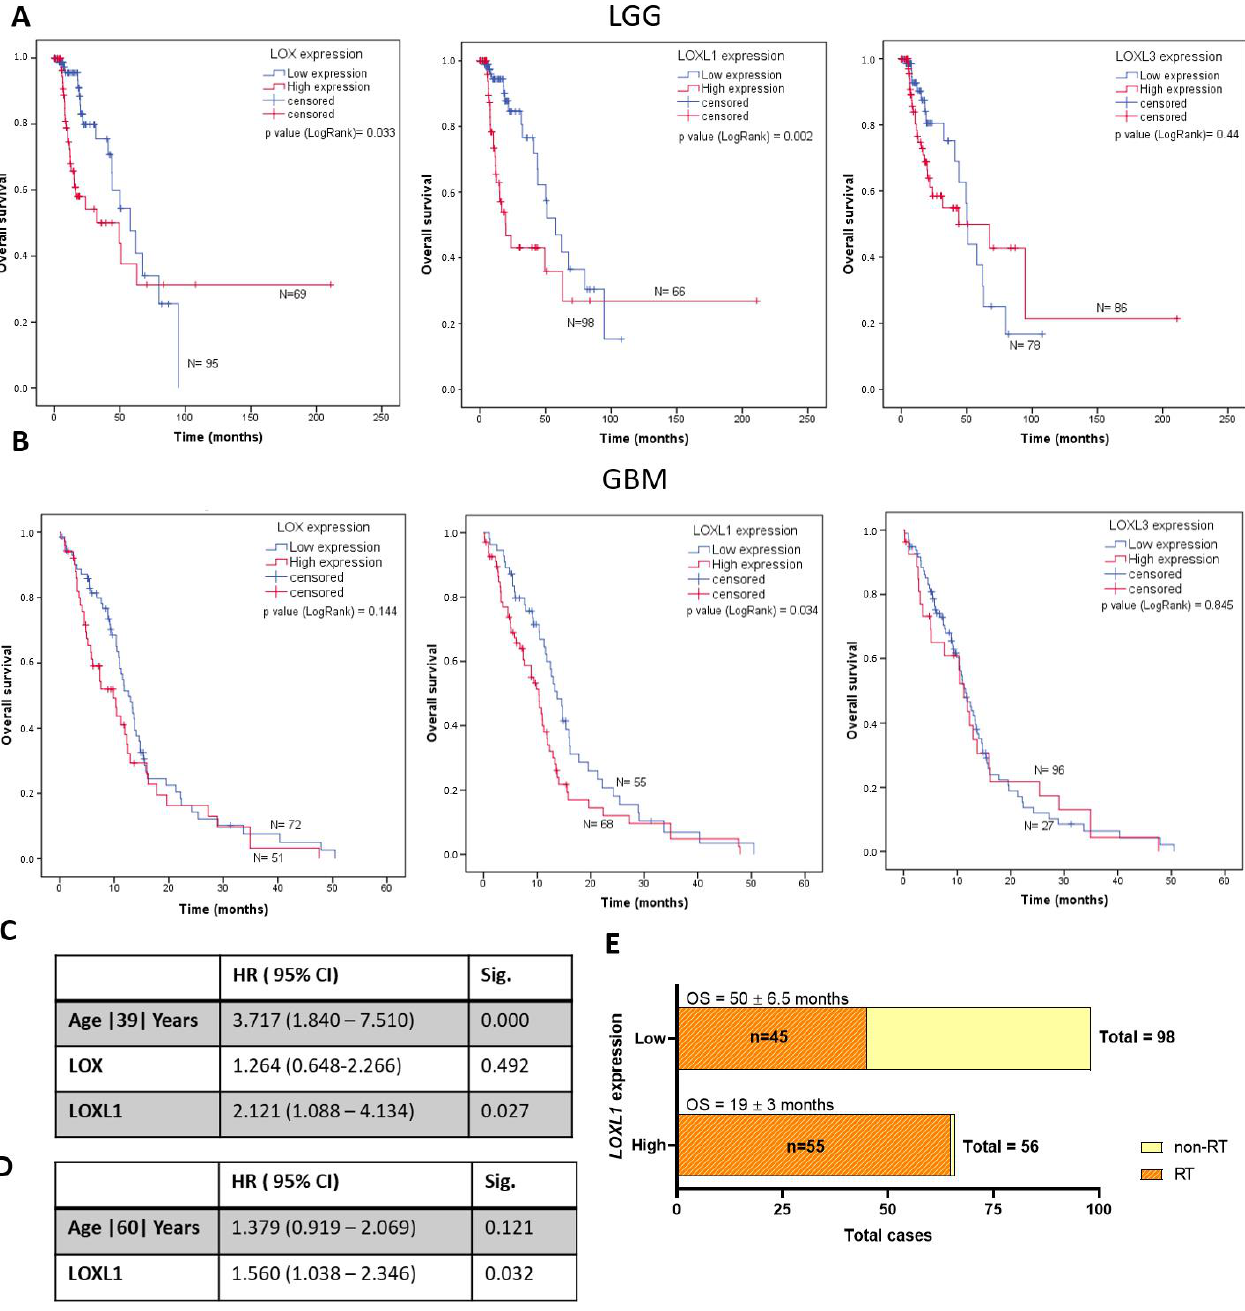
Figure 3. Overall survival curves of LOX family in LGG and GBM cohort in TCGA database. ( A )